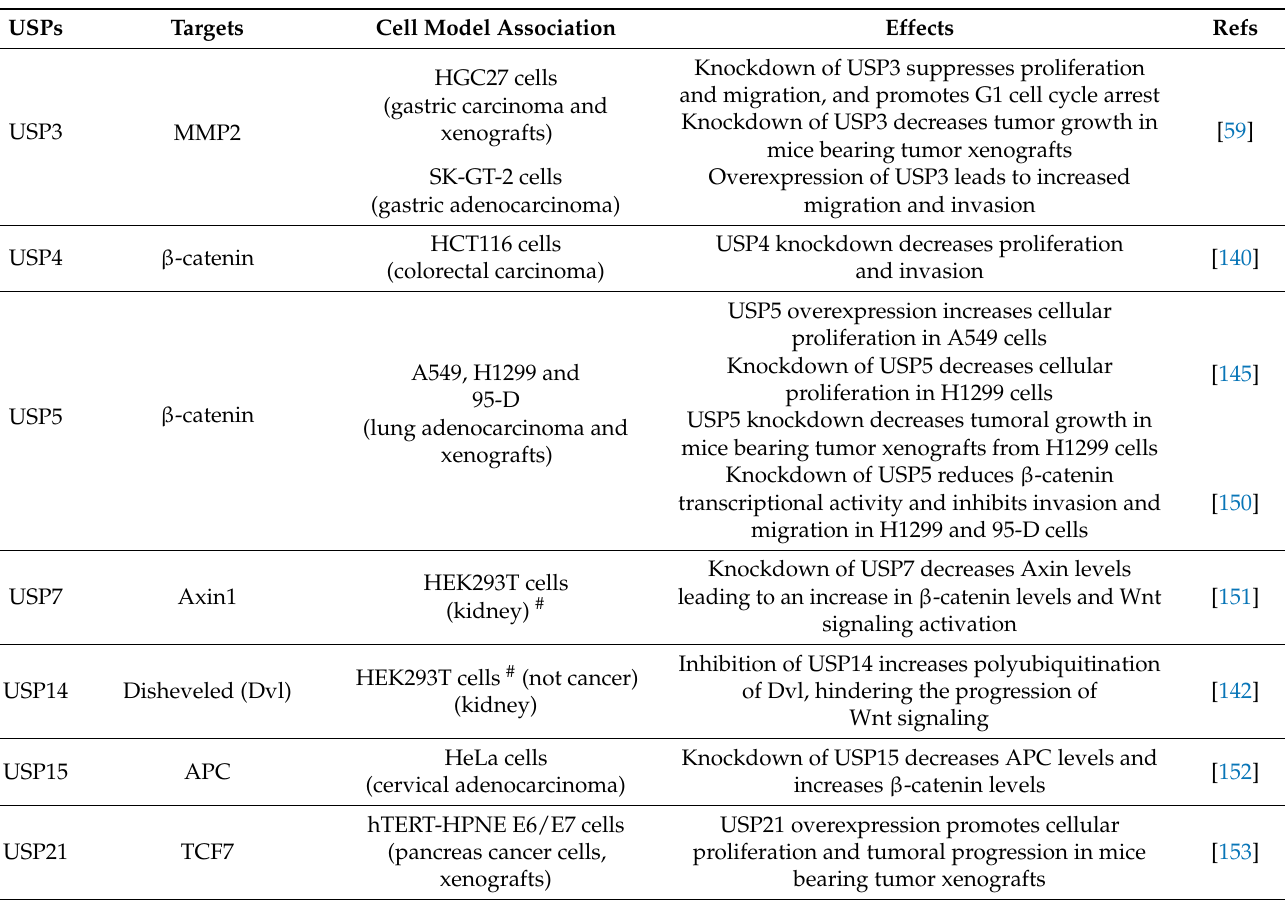
Table 5. Summary of cellular consequences resulting from interactions between different USPs and target proteins associated with the Wnt signaling